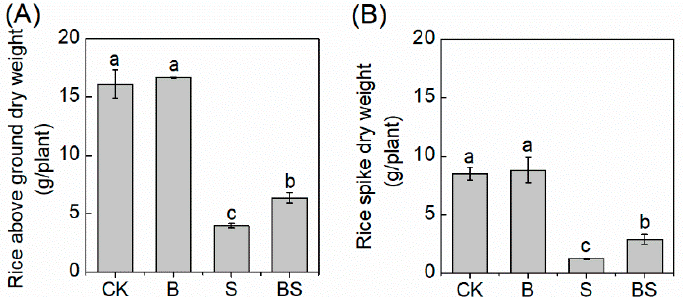
Figure 1. Effects of different treatments on rice aboveground dry weight ( A ) and rice spike dry weight ( B ). Columns with different letters are significantly different at p < 0.05. CK: organic substitution; B: organic substitution + biochar; S: CK + NaCl; BS: B + NaCl.